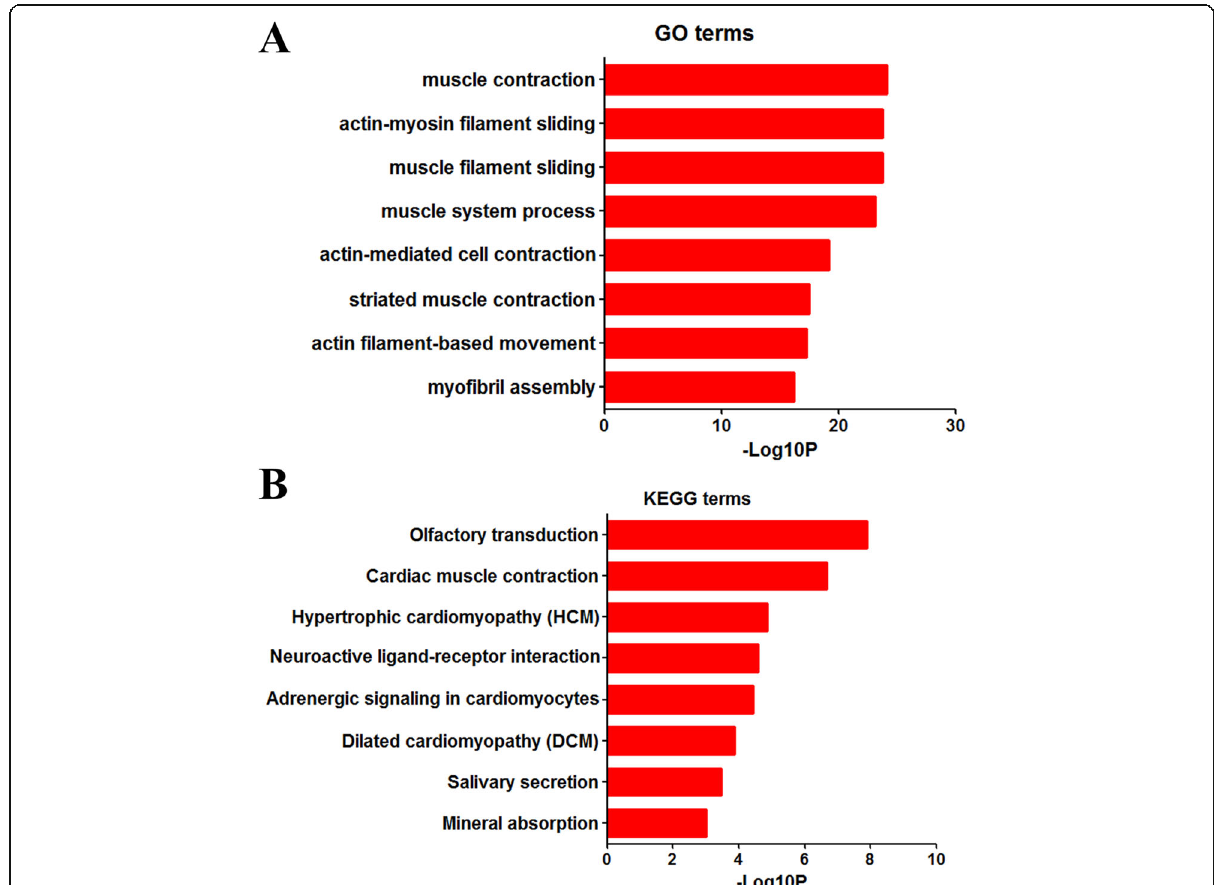
Fig. 5 Functional enrichment results of differentially expressed genes. A. Top 8 pathways identified in the GO enrichment analysis in DEGs. B. Top 8 pathways identified in KEGG pathway analysis in